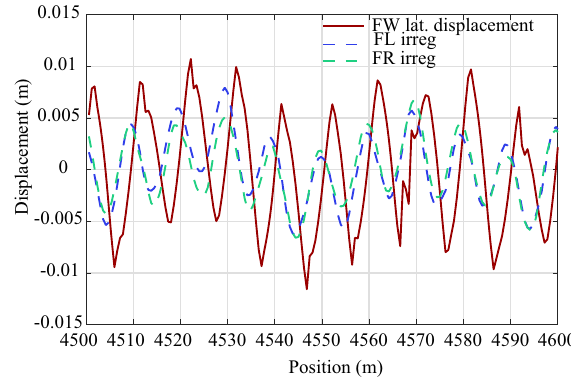
Fig. 12 Simulation with centerline variations with 4 mm amplitude and 10 m wavelength in the interval 4500–4600 m. The figure is a zoomed-in version of Fig.